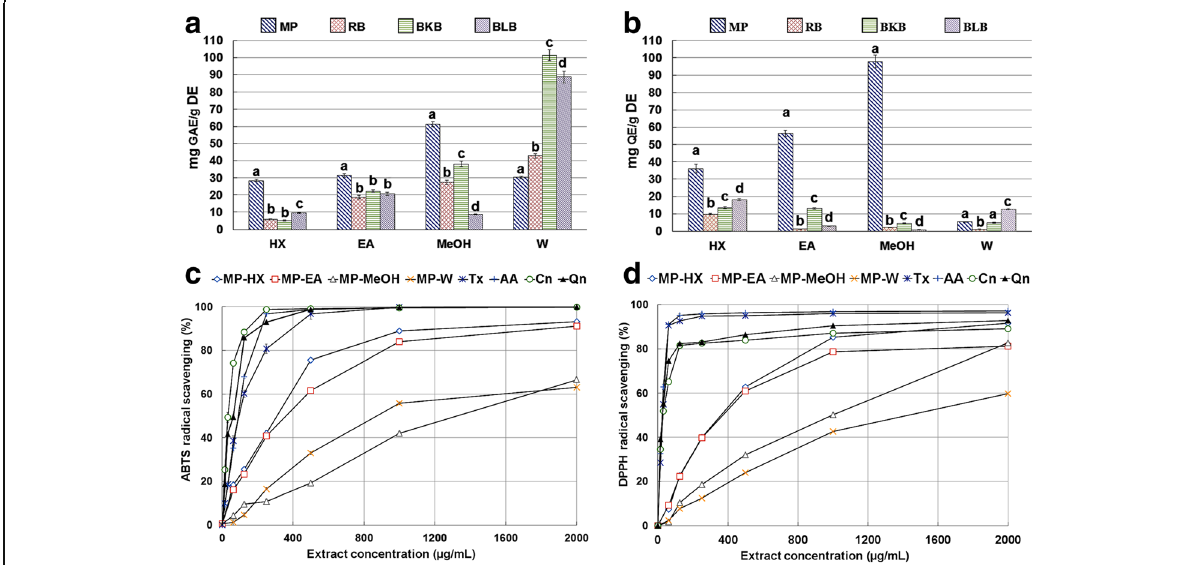
Fig. 1 Determination of antioxidant components and in vitro antioxidant activities of MP leaf extracts. ( a ) Total phenolic content, ( b ) Total flavonoid content, ( c ) ABTS radical-scavenging, and ( d ) DPPH radical-scavenging. Values are mean ± SD ( n = 3). RB, raspberry; BKB, blackberry; BLB, blueberry; HX, hexane; EA, ethyl acetate; MeOH, methanol; W, water. Means with different letters (a-d) are significantly different ( p < 0.05). GAE, gallic acid equivalent; QE, quercetin equivalent; DE, dried extract; Tx, trolox; AA, ascorbic acid; Cn, catechin; Qn,